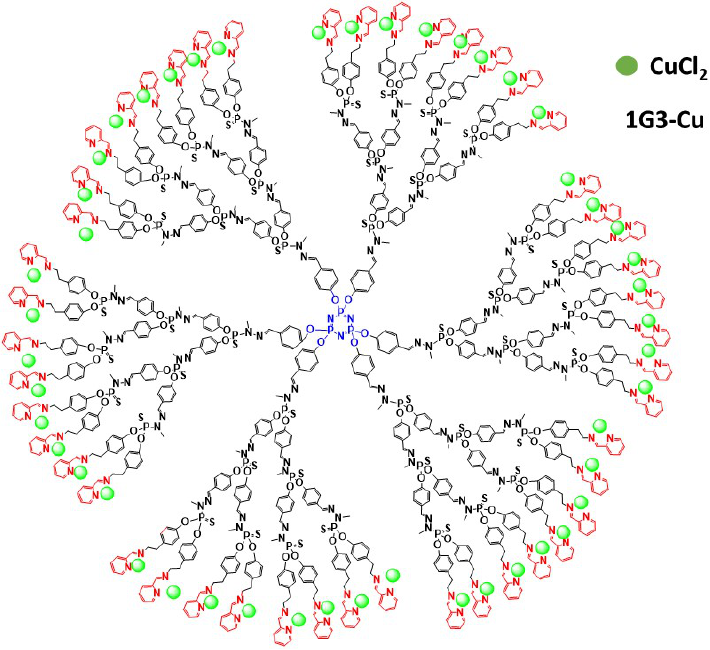
Figure 2. Schematic depiction of 2D chemical structure of